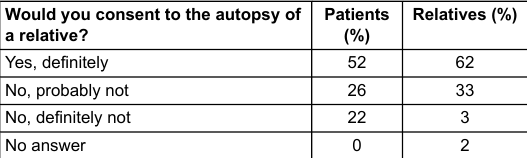
Table 7: Consent to the autopsy of a relative (questionnaire 2).